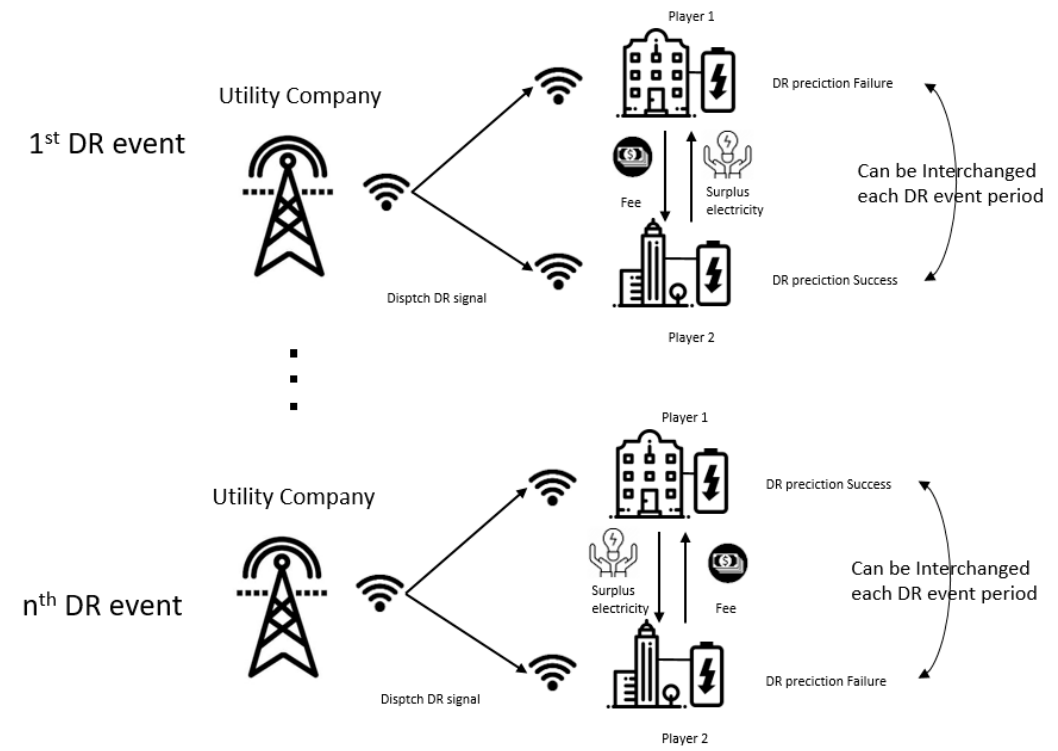
Figure 5. Schematic of Indirect Energy Trading.